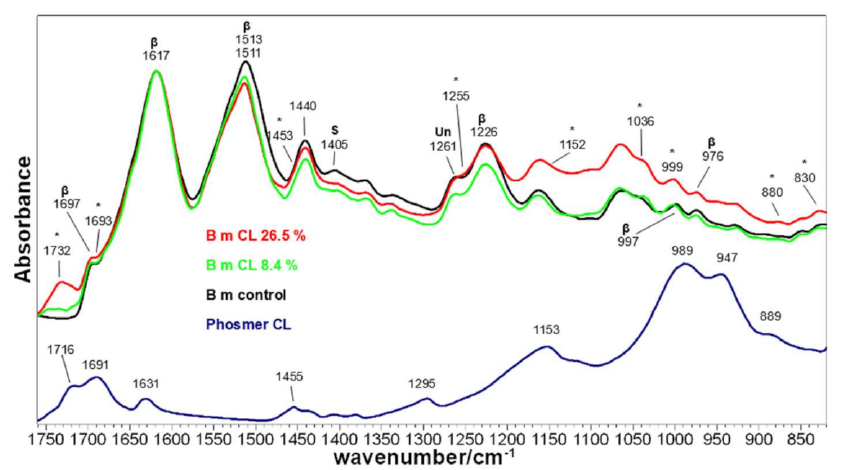
Figure 5. IR spectra of B. mori silk fibroin fabrics before (control) and after grafting with phosmer CL (weight gains 8.4% and 26.5%). The spectra are normalized to the Amide I band at 1617 cm − 1 . The spectrum of phosmer CL is reported for comparison. Asterisks (*) indicate the main spectral features ascribable to phosmer (see Supplementary Material for assignments). The main bands assignable to β -sheet conformation ( β ), unordered (Un) structures and serine (S) are